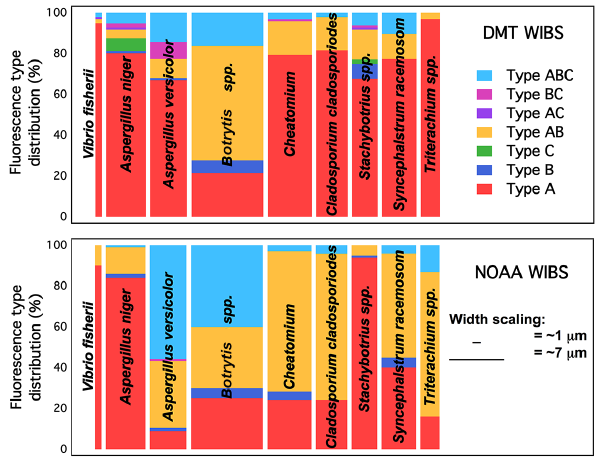
Figure 4. Comparison of fluorescence type distributions for two dif- ferent WIBS instruments from a subset of the pure bioaerosol cul- tures and pollen grains used in this analysis. The top panel shows distributions from the DMT WIBS, which was used for all of the bioaerosol chamber challenges presented here. The bottom panel shows the fluorescence type distributions from the NOAA WIBS, used in parallel for a subset of the bioaerosol chamber challenges using pure cultures of bacterial cells and fungal